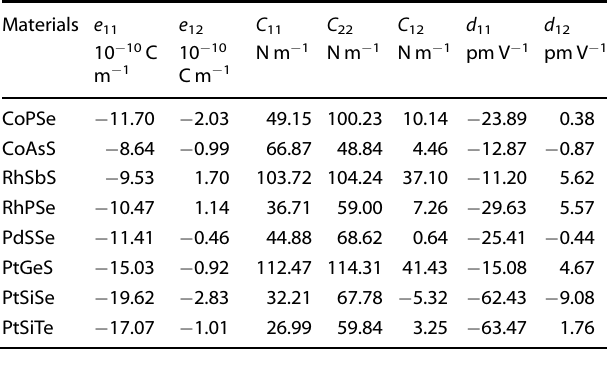
Table 1. Piezoelectric coef fi cients for the eight non-metallic ternary pentagonal sheets.